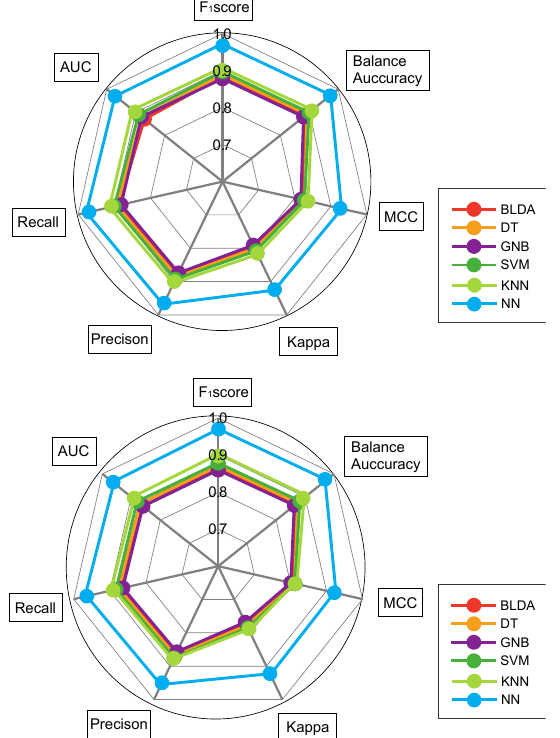
Figure 5. Radar plot of the training phase ( above ) and test ( below ) for the classification of bipolar